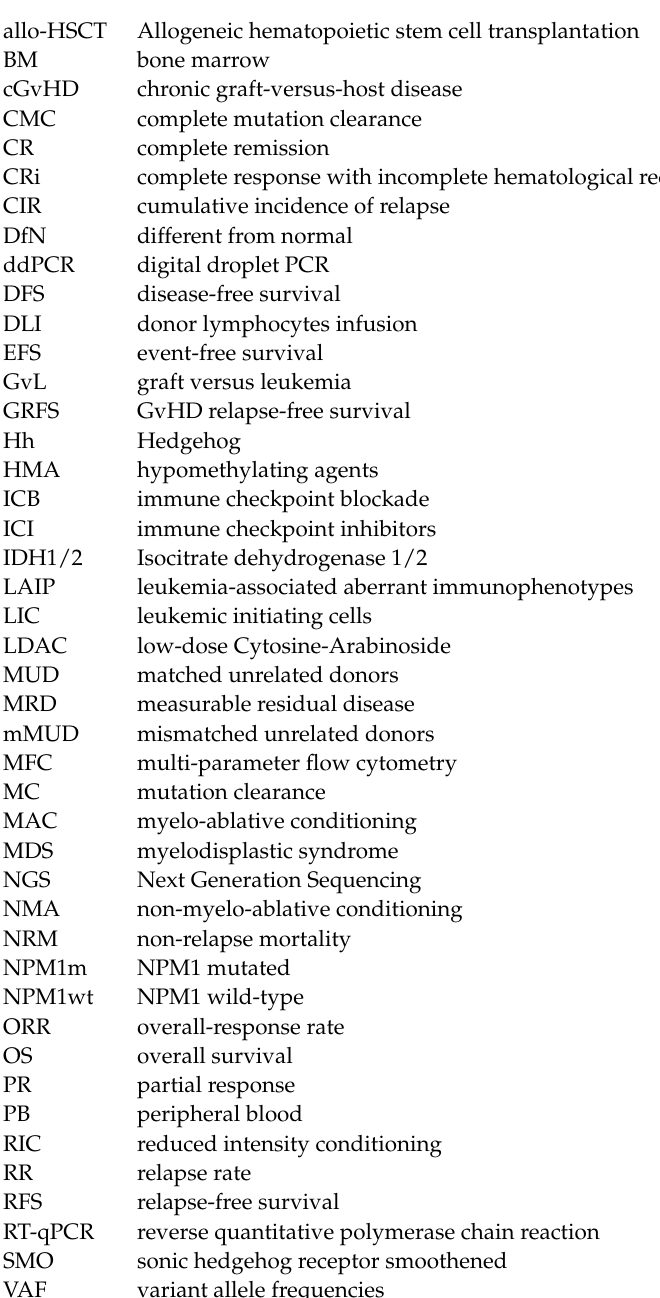
Table S2: most relevant MRD studies in AML with